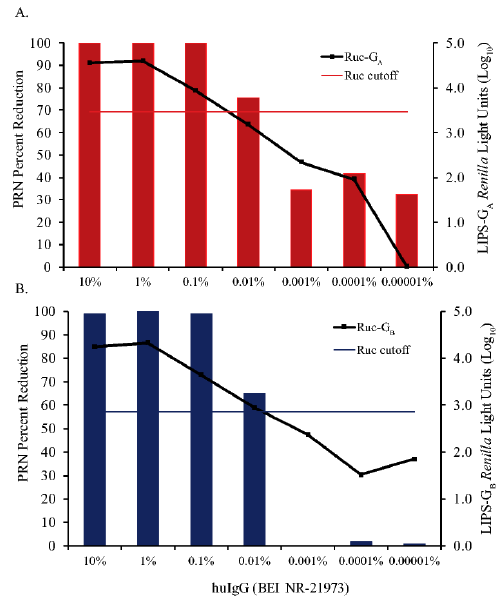
Figure 4. Detection of anti-RSV antibodies using LIPS-G A and -G B assays versus plaque reduction neutralization (PRN) testing. Human immune globulin (huIgG, BEI NR-21973) was used neat or serially diluted 10-fold into Ig ∆ from 10% to 0.00001% IgG. Samples were tested in triplicate in immunoprecipitation assays and in duplicate in plaque reduction neutralization assays against Ruc-G A antigen and RSV-A2, respectively (panel A ) or against Ruc-G B antigen and RSV-B1, respectively (panel B ). The results of testing in the immunoprecipitation assay are shown by the black lines in each figure. Cutoff values for a positive result in the immunoprecipitation assays were five standard deviations above the mean value of the negative control (Ig ∆ ) and are shown as horizontal red (Ruc-G A ) and blue lines (Ruc-G B ). In the PRN test, a reduction in the mean plaque count of ≥ 50% (in wells containing huIgG) relative to the mean plaque count seen in virus control wells (in the absence of huIgG) was considered